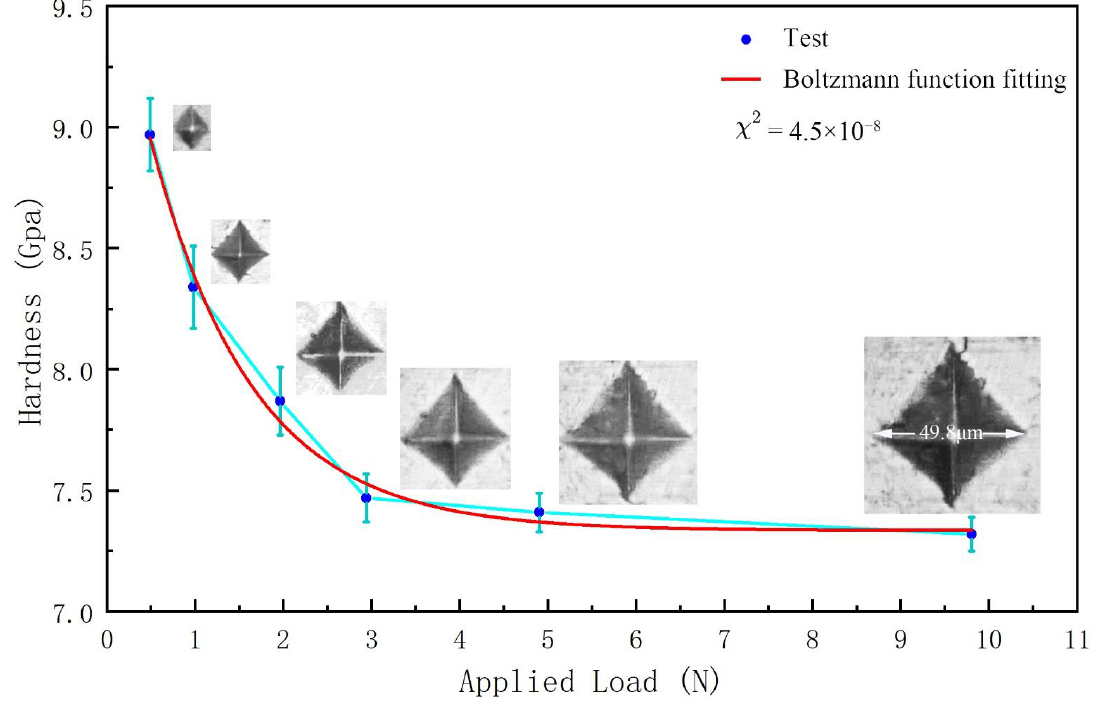
Figure 4. Vickers hardness for Mn 2 N 0.86 . The applied load ranged from 0.49 N (low load) to 9.8 N (high load). Typical optical images of the indentation are shown in the inset. To gain a deeper understanding of the co-existence of ferro- and antiferromagnetism in our sample, we conducted first-principle DFT simulations of Mn 2 N 0.86 . The band struc- ture and spin density of states (spin-DOSs), shown in Figure 7, indicate that Mn 2 N 0.86 is metallic because of the overlapping bands at the Fermi level. Moreover, the DOSs for dif- ferent spins are symmetric, which means Mn 2 N 0.86 should be antiferromagnetic. The fer- romagnetism might originate from the N vacancies. XRD and EDS are insufficiently sen- sitive to minute amounts of N vacancies. We simulated the latent heat of Mn 2 N from both the antiferromagnetic and ferromagnetic phases to the nonmagnetic phase with the for- mer being approximately 5% of the latter. Then, using these values to fit the exothermic peak in Figure 5b near 600 K, we determined that the Mn 2 N might be 95% antiferromag- netic and 5% ferromagnetic. Although we do not consider Mn 2 N and Mn 2 N 0.86 to be equal, the analogy could serve as a helpful indication.